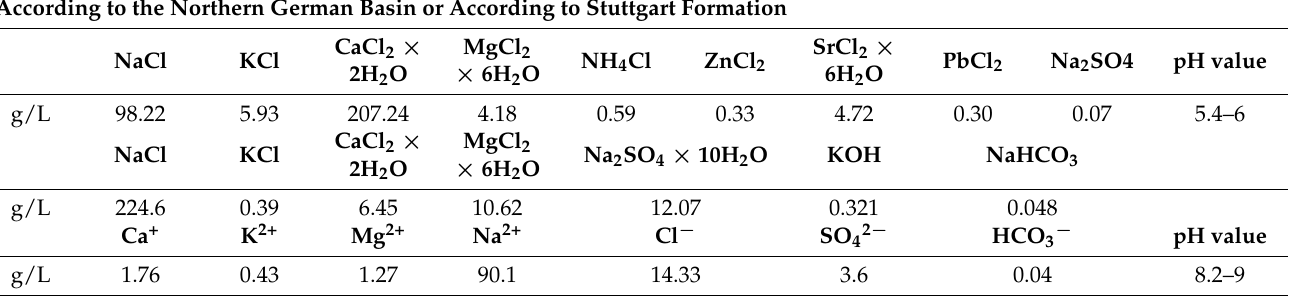
Table 3. Northern German Basin (NGB) and Stuttgart Formation electrolyte: Chemical composition.